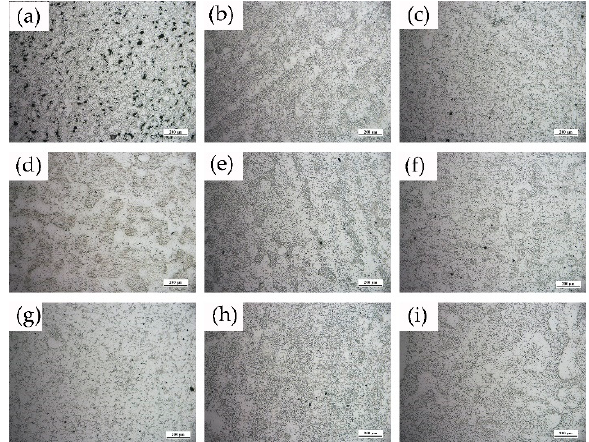
Figure 7. The transverse morphologies of different VEDs. ( a ) 185.19 J/mm 3 ; ( b ) 277.78 J/mm 3 ; ( c ) 396.83 J/mm 3 ; ( d ) 518.52 J/mm 3 ; ( e ) 592.60 J/mm 3 ; ( f ) 617.28 J/mm 3 ; ( g ) 634.92 J/mm 3 ; ( h ) 648.15 J/mm 3 ; ( i ) 777.78 J/mm 3 .